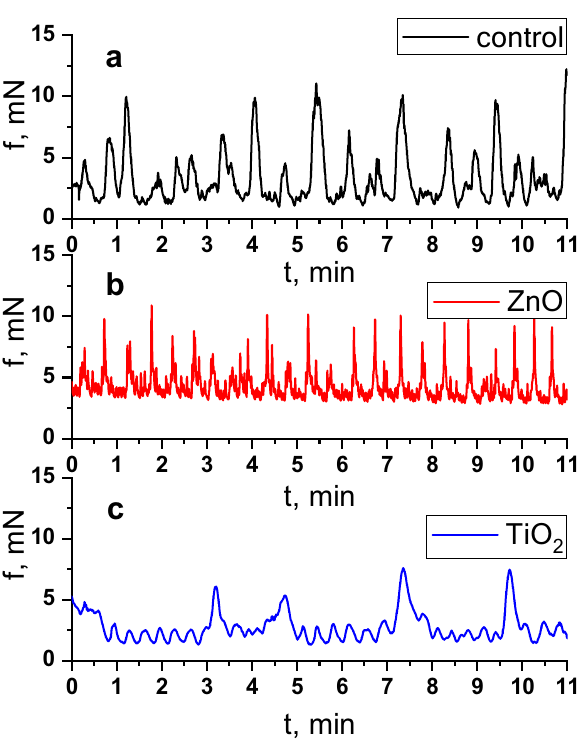
Figure 2. Spontaneous contractile activity of the circular SMs of the caecum of rats: ( a ) control group; ( b ) and ( c ) groups of rats burdened for 6 months with ZnO and TiO 2 ANs,